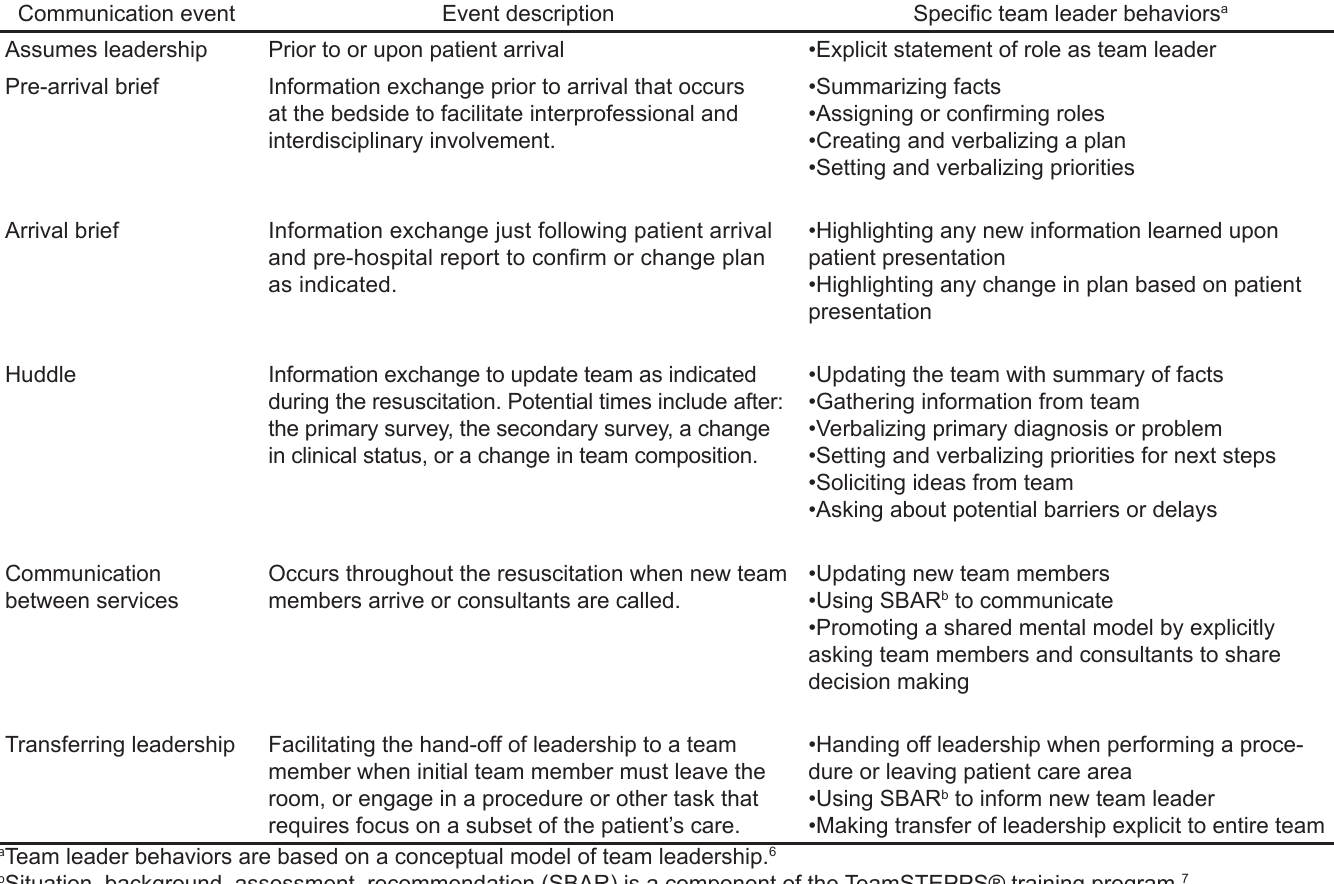
a Team leader behaviors are based on a conceptual model of team leadership. 6 b Situation, background, assessment, recommendation (SBAR) is a component of the TeamSTEPPS® training program. 7